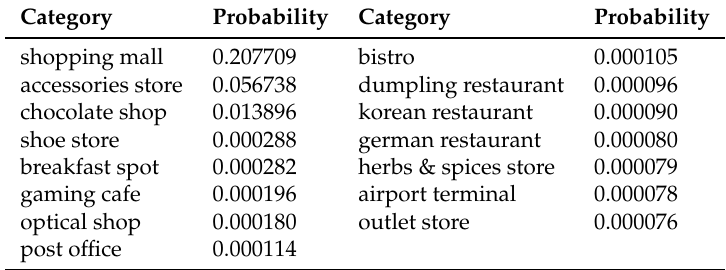
Table A1. Top-15 ranked point of interest (POI) types for the “shopping plaza” topic in [12].